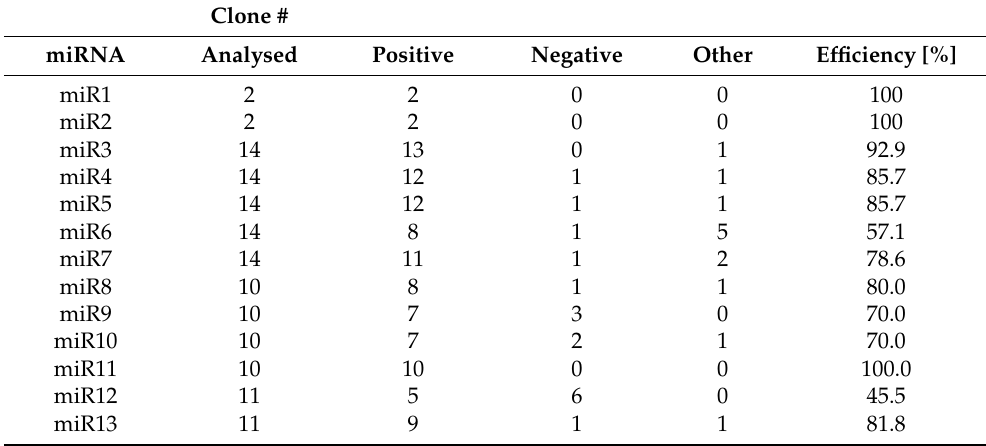
Table 1. Efficiency of miRNA insertion. Thirteen different miRNAs were inserted in Ad-miRNA- rpslneo and the obtained clones were analysed by either digestion with restriction enzymes (miR1, miR2) or colony PCR (miR3–miR13). Positive refers to clones tested for successful miRNA insertion; negative refers to clones tested for unsuccessful miRNA insertion; other refers to ambiguous results. Of the analysed clones, at least 45.5% proved to be positive, with an average cloning efficiency of 80.6 ± 16.7%. # is the number of